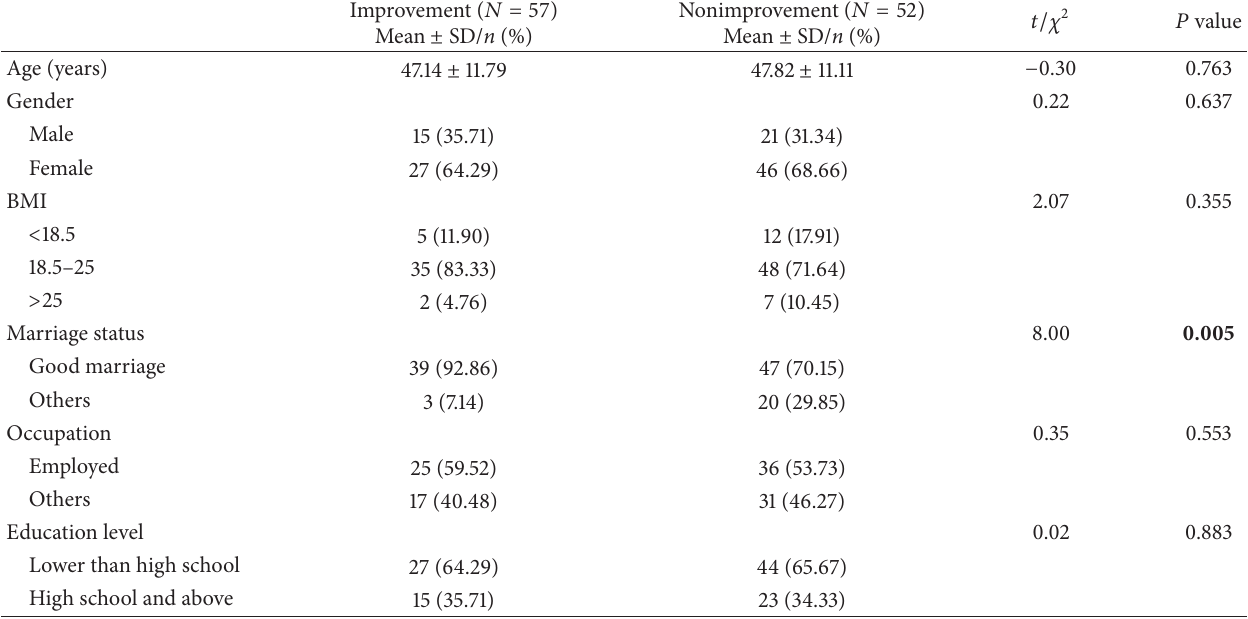
Table 1: Demographic characteristics of Chinese FD patients.